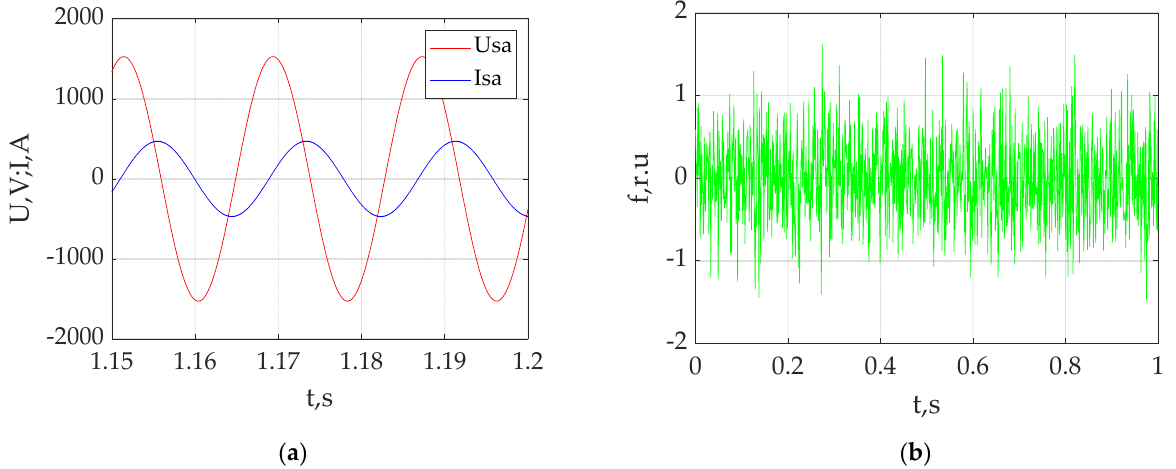
Figure 5. Time diagrams: ( a ) of the stator current and phase voltage of phase A for the steady − state mode; ( b ) ‘white − noise’ − type of interferences.